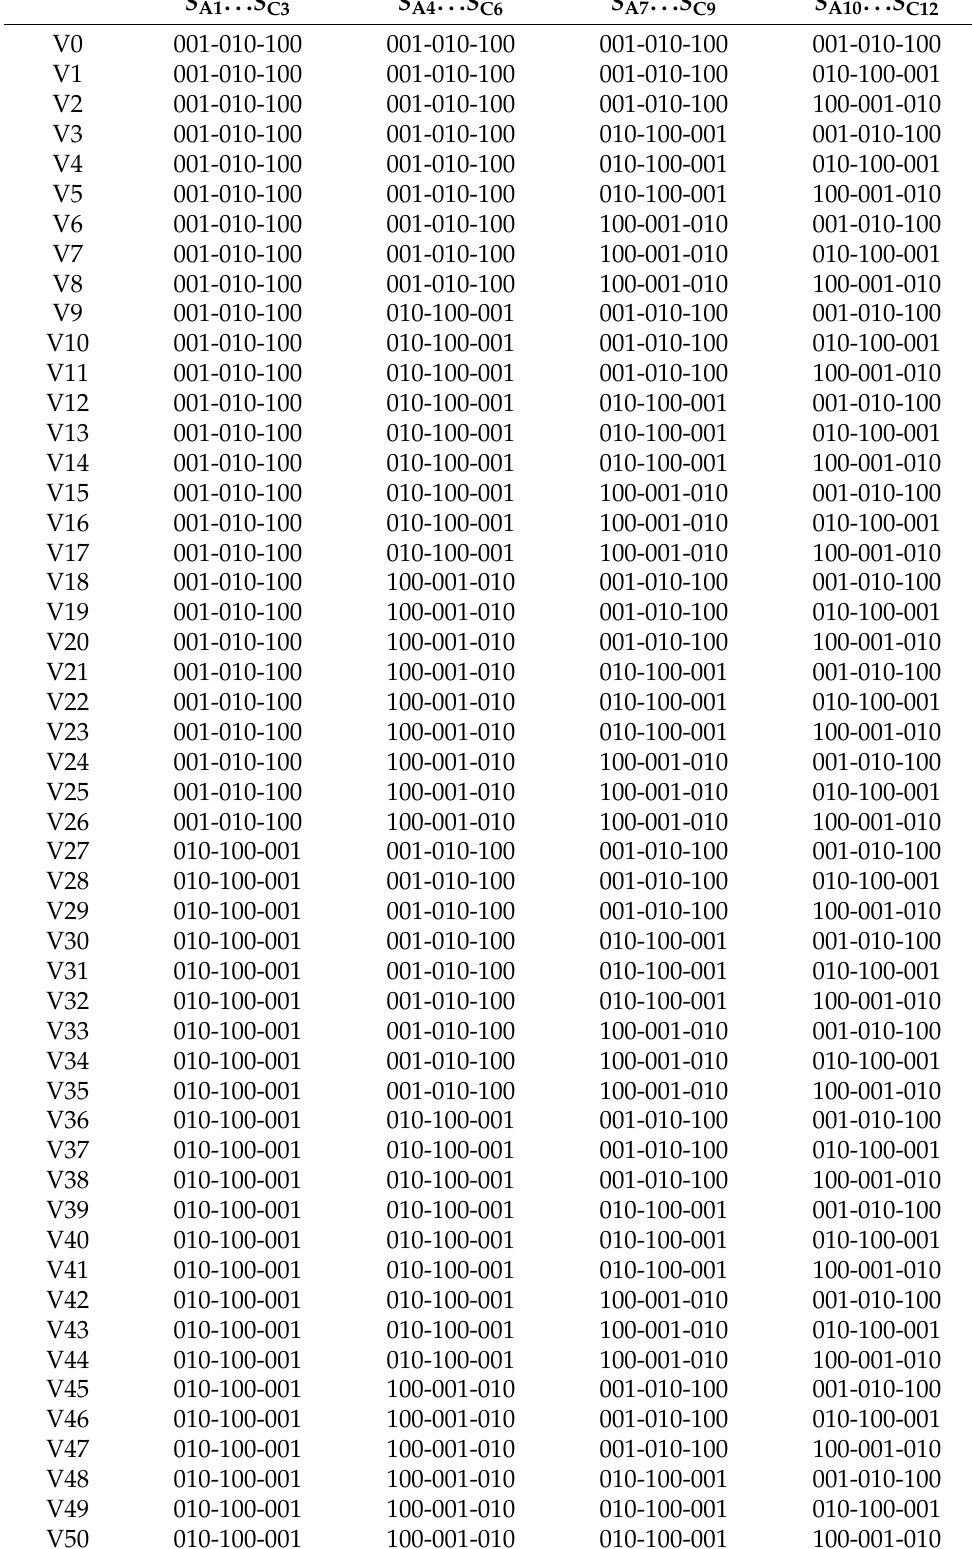
Table A2. The S MC p Switch